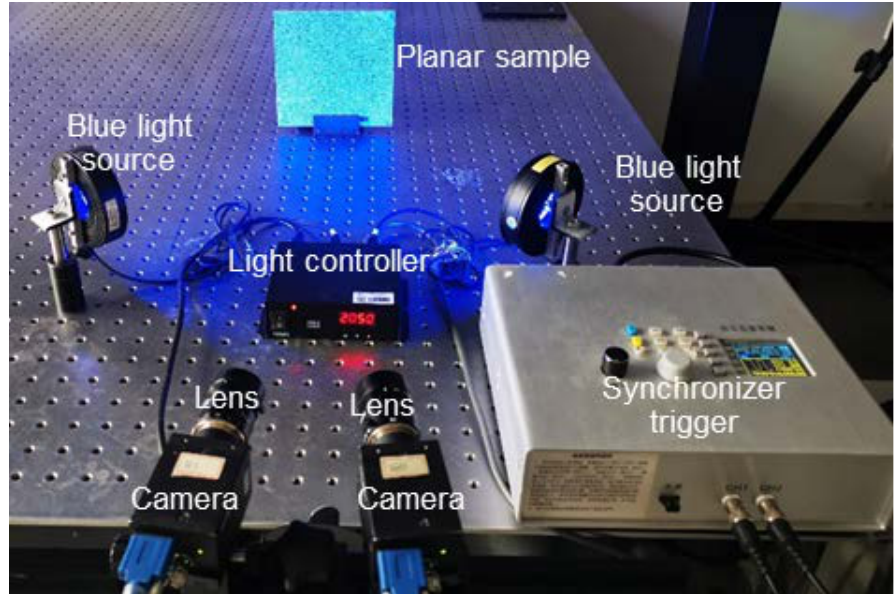
Figure 4. Sketch map of the experimental setup for validation tests. Before the tests, the intrinsic and extrinsic parameters of the stereo-DIC system were calibrated under the light intensity of 50 level with an exposure time of 600 ms. Then a planar specimen (size: 150 mm × 150 mm × 3 mm) decorated with the artificial spray paint speckle on the surface was kept stationary on the optical platform. In the reference state (i.e., the light intensity is 50 level), the apertures of the two lenses were carefully adjusted to ensure the AG of the left and right images in the same level. Then, one seemingly good reference image pair was captured at the fixed exposure time of 600 ms. For comparison, the exposure time of the two cameras was then adjusted with the proposed method to determine the optimal exposure time for capturing the optimal reference image pair. In performing this, the maximum MIG value of 28.26 was determined for the left image at the exposure time of t opt _L =682 ms, while the maximum MIG value for the right image was found as 26.80 at the exposure time of t opt _R = 719 ms. Meanwhile, the optimal AG values corresponding to the maximum MIG values of the left and right images were obtained ( g opt _L = 149, g opt _R = 151). The ideal AG value was thus set as g opt ( g opt _L + g opt _R )/2 = 150. With this value, the optimal exposure time for the two cameras is determined as t opt =687ms (( g opt / g opt _L ) × t opt _L ). Then the optimal reference image pair was also captured with the determined optimal exposure time. As a result, the calculated MIG values of the optimal reference image pair (28.26 and 26.78) were higher than the comparison group (fixed mode) of 26.41 and